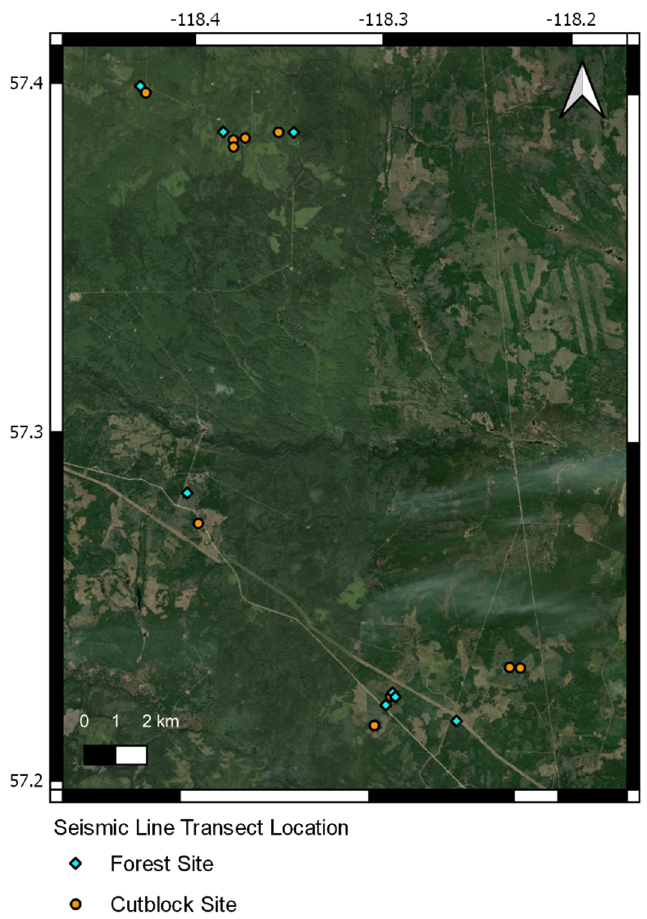
Figure A1. Location of all seismic line areas sampled. Stand type is indicated as either a blue diamond (unmanaged forest) or an orange circle (Cutblock).